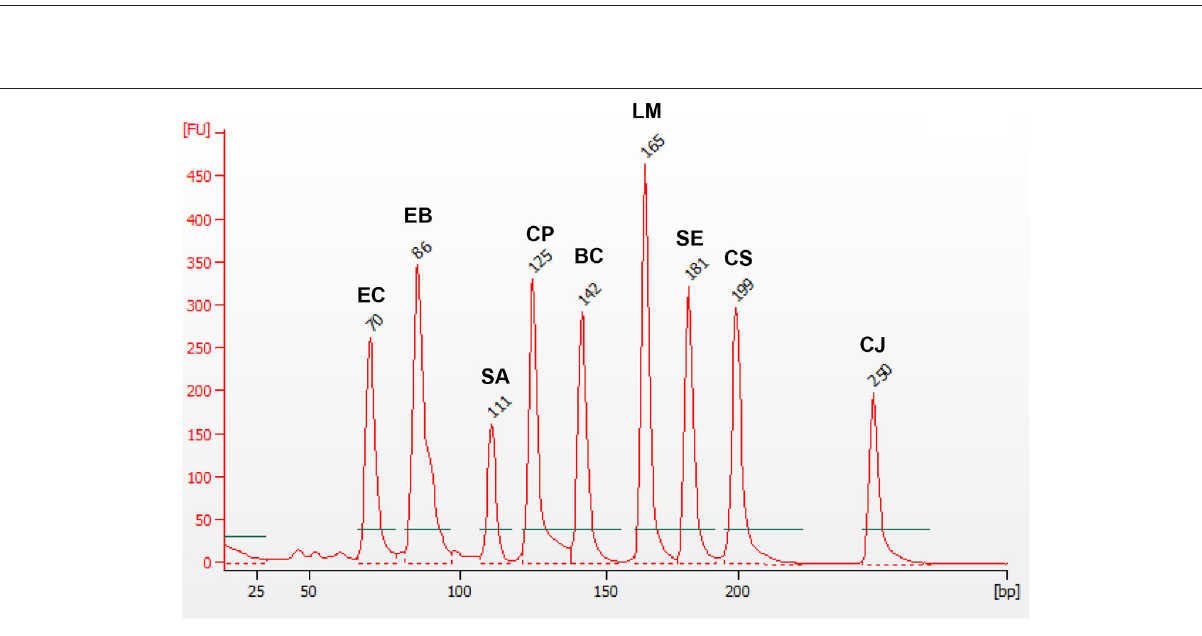
FIGURE 2 | mPCR with 9 pairs of primers and gDNA of B. cereus (BC), C. jejuni (CJ), Cl. perfringens (CP), Cr. sakazakii (CS), E. coli (EC), F. Enterobacteriaceae (EB), L. monocytogenes (LM), Salmonella spp. (SE), and St. aureus (SA), at Tm = 56 ◦ C. The values showed on each peak, corresponds to the size detected for each